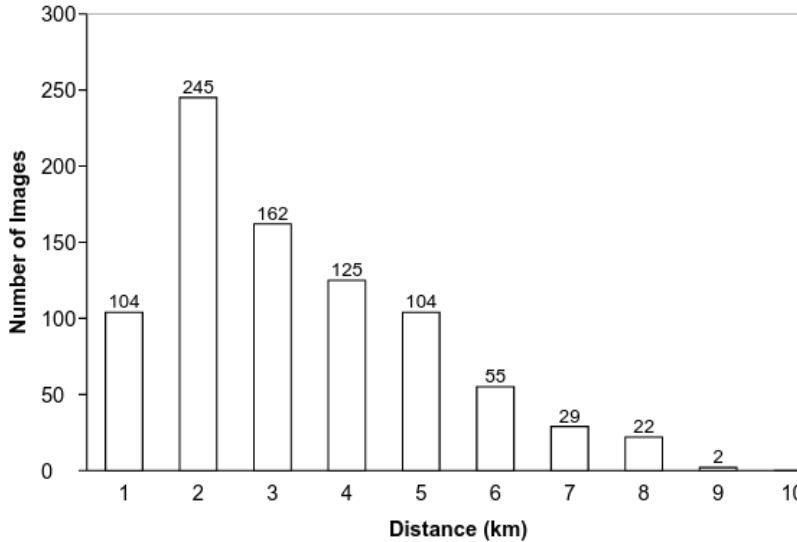
Figure 8. Urban Nature images in relation to distance from Copenhagen’s city centre (r =